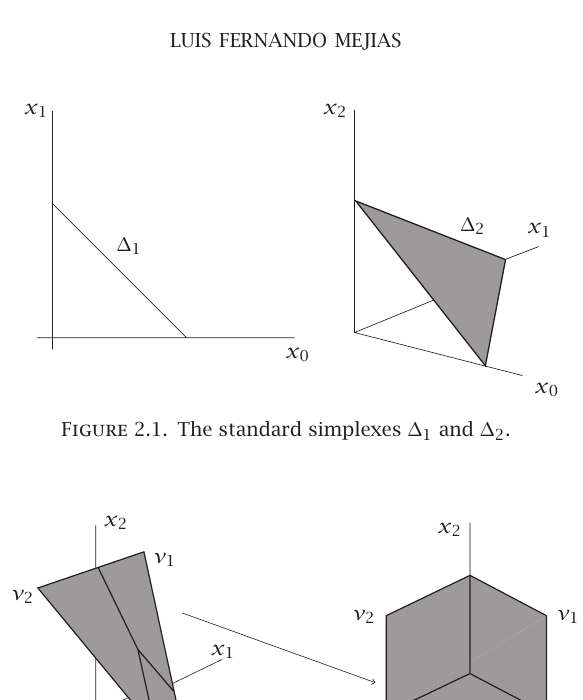
Figure 2.2 . The 2-simplexes ∆